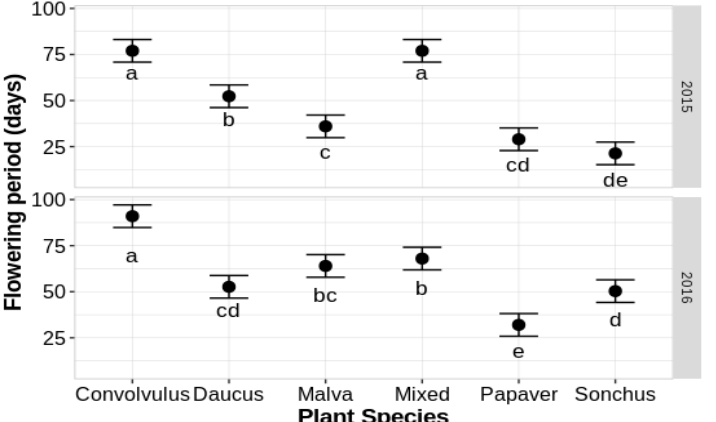
Figure 2. Differences in the lengths of the flowering periods between flower treatments in both years of the study (2015 and 2016). Values are the estimated marginal means from the general mixed-effects model. Bars show confidence intervals at the 0.95 level. Letters indicate differences between treatments derived from post hoc pairwise comparisons using the Tukey method for p -value adjustment. Contrasts were performed between treatments and for each year separately. Flower species are indicated by genus.